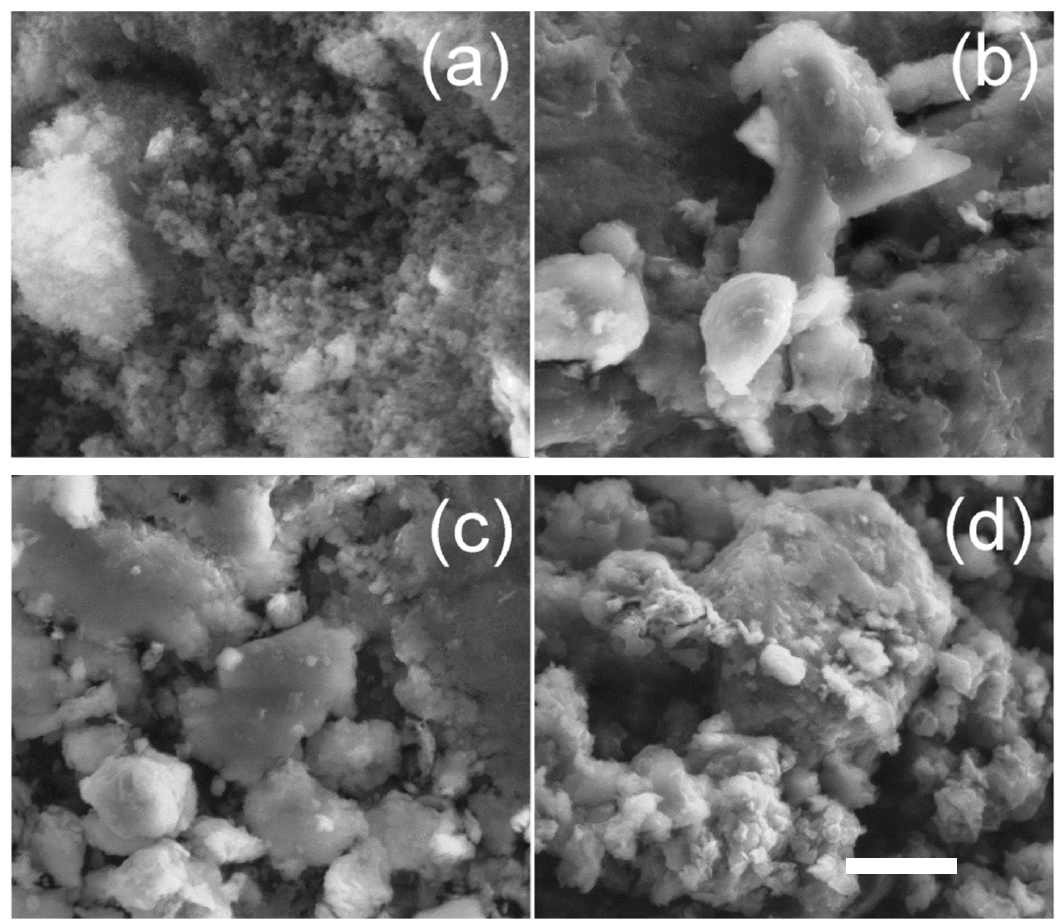
Figure 6. Scanning electron microscope (SEM) images of: ( a ) TiC; ( b ) PANI@TiC; ( c ) TiO 2 –TiC; and ( d ) PANI@TiO 2 –TiC. Scale bar indicates 5 µm.